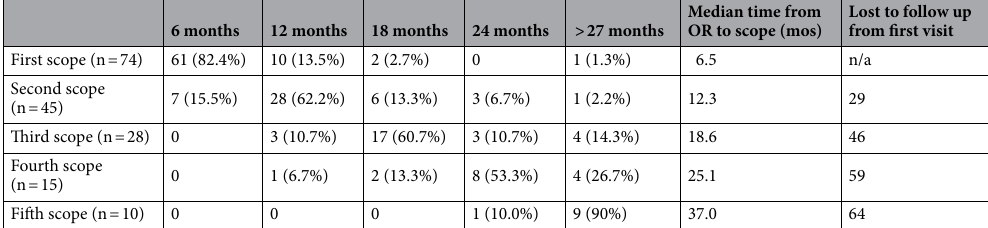
Table 3. Timing of Endoscopic Follow-up post TEM. Endoscopy was recorded as meeting a timeframe if it occurred within 3 months of that timeframe.